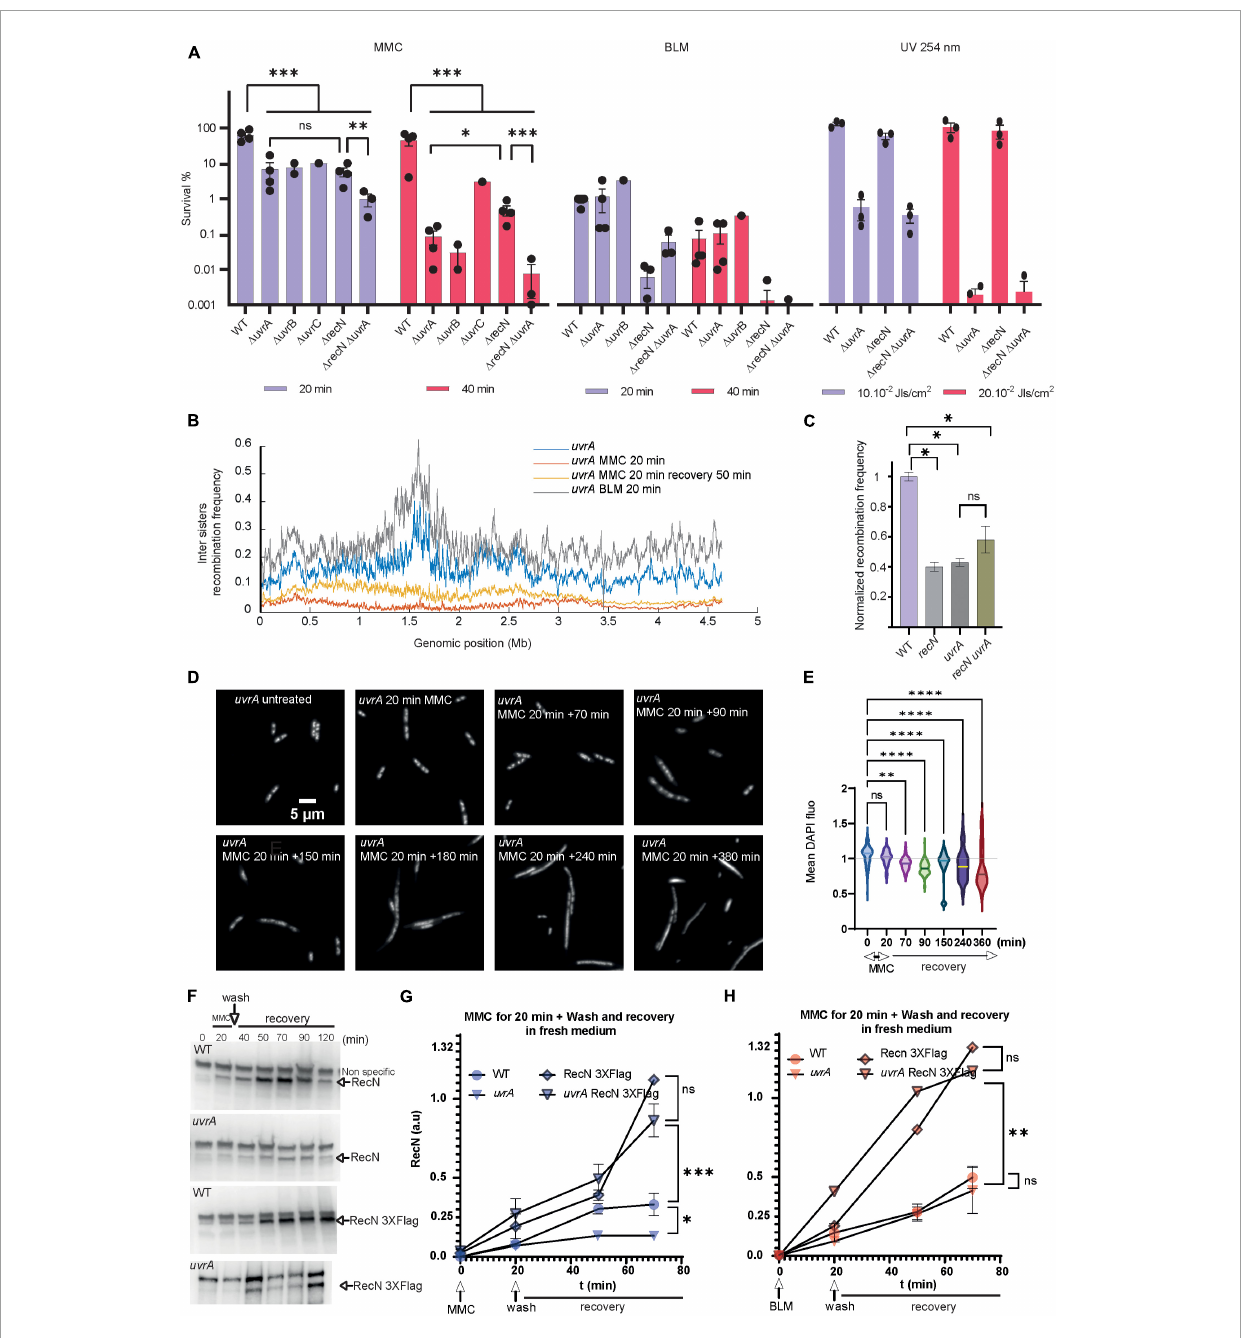
FIGURE5 Role of the NER in the GSR associated with BLM and MMC lesions. (A) CFU analysis of the WT, recN , uvrA , uvrB , uvrC single, and double mutants in the presence of MMC, BLM, and UV irradiation. Anova statistical test ∗ < 0.05, ∗∗ < 0.005, ∗∗∗ < 0.0005, ∗∗∗∗ < 0.00005. (B) Hi-SC2 profile of sister chromatid interactions in the uvrA mutants in the presence or absence of MMC and BLM. (C) Measure of inter sister locus recombination, laclox assay at the aidB locus (Vickridge et al., 2017), in the WT, recN , uvrA, and recN uvrA mutants. (D) Nucleoid imaging of the uvrA mutant during the recovery period of MMC injury. (E) Quantification of the mean DAPI fluorescence in the nucleoid area of uvrA mutant treated with MMC. Anova statistical test ∗ < 0.05, ∗∗ < 0.005, ∗∗∗ < 0.0005, ∗∗∗∗ < 0.00005. (F) Western blot showing RecN and RecN 3XFlag amount in WT and uvrA cells during GSR recovery. (G) Quantification of RecN amount in 3 western blot experiments performed as in panel F in the WT and uvrA mutant during the recovery period of MMC injury. RecN amount was normalized to the amount of RNA polymerase β in each sample. (H) Measure of RecN and RecN 3X-flag turnover in the WT and uvrA mutant during the recovery period of BLM injury ( N = 3 western blots performed in identical conditions).